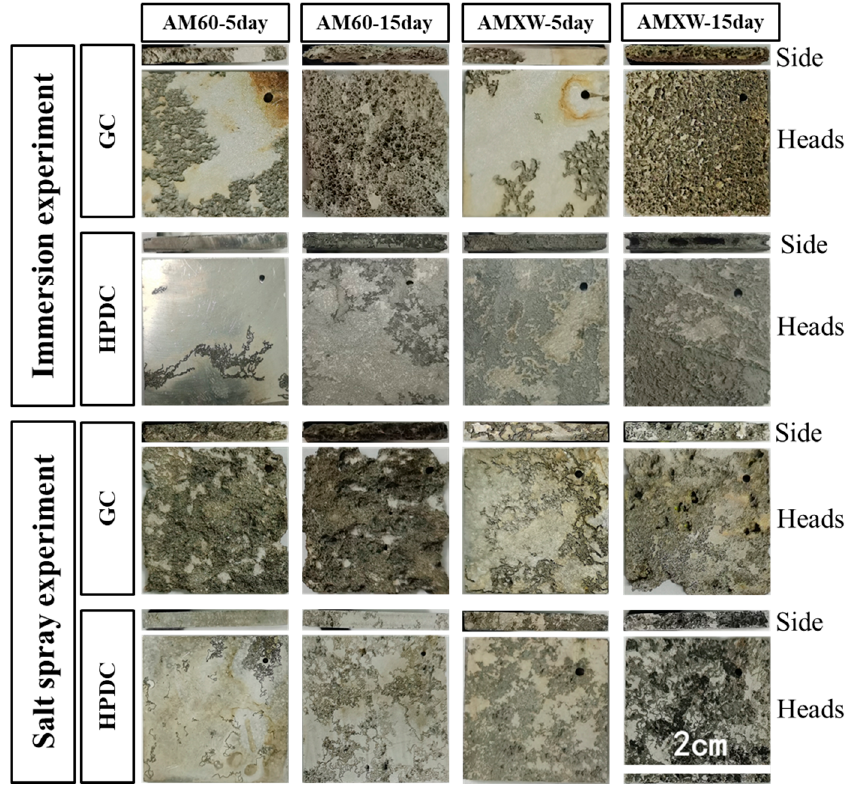
Figure 10. Macro-morphology of corroded surface & side under IT and SST after 5 and 15 days.